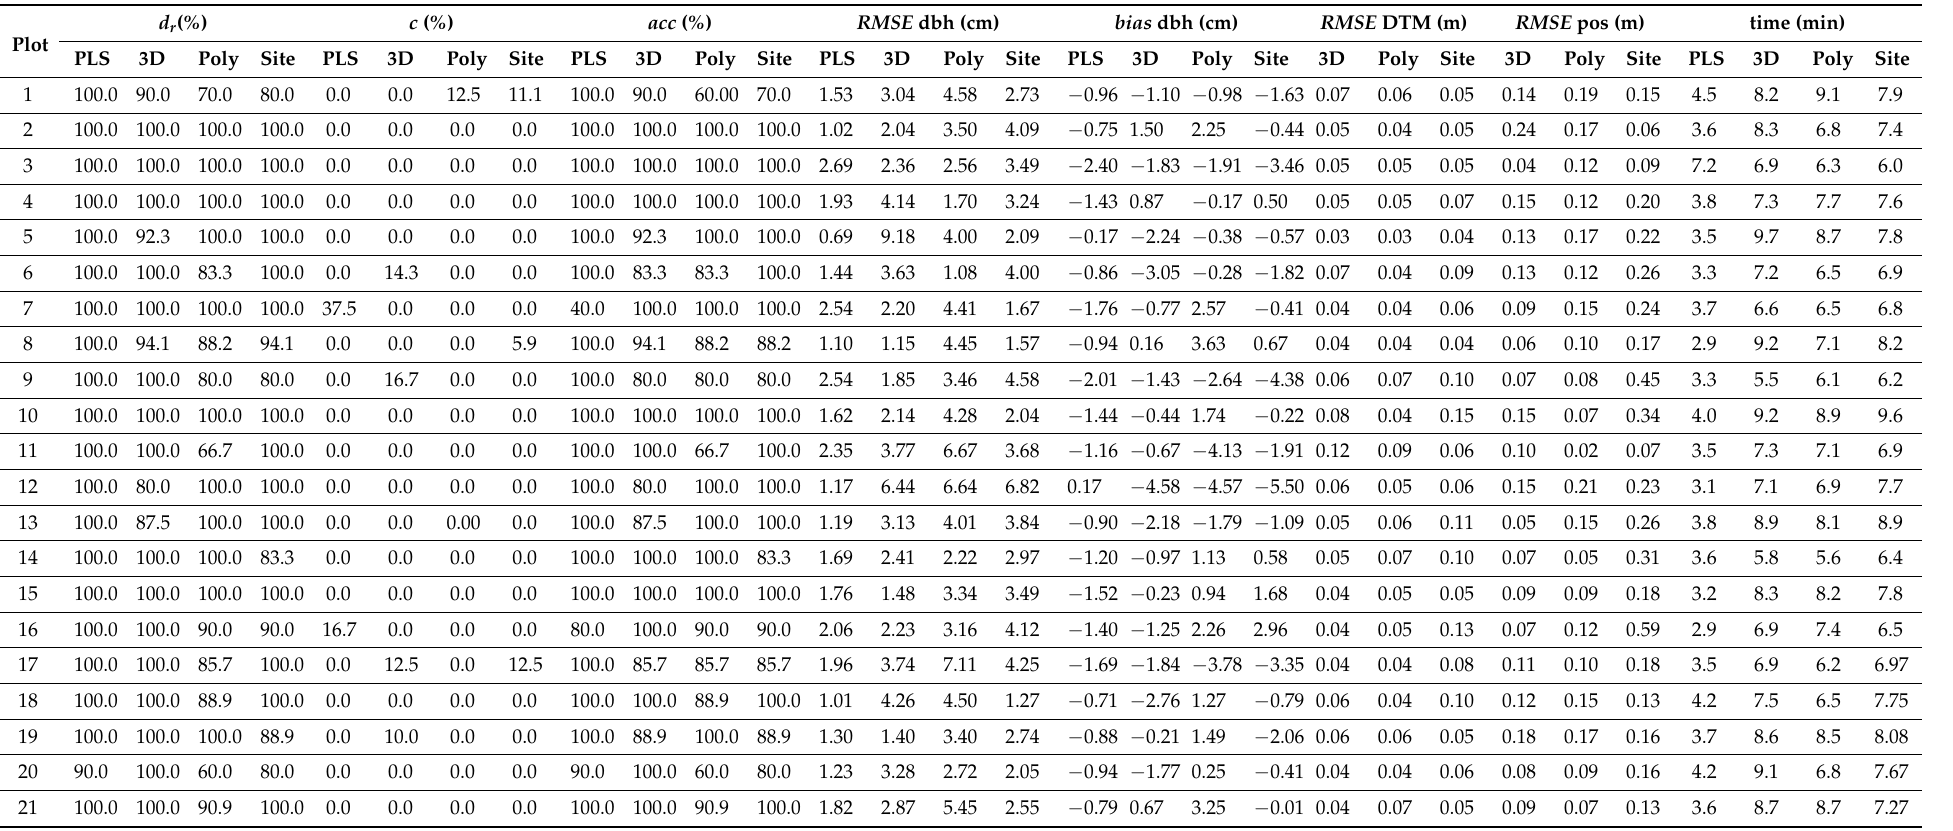
Table A5. Performance of tree detection, diameter estimation, and DTM modeling for iPad/PLS with a lower dbh threshold of 10